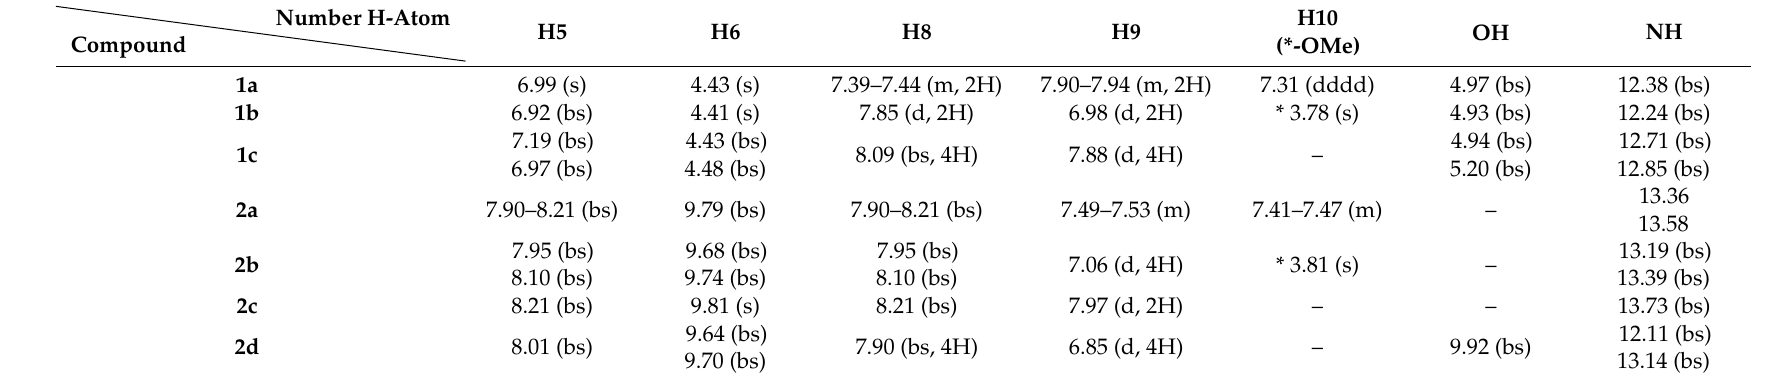
Table 1. Assignments of the signals from the 1 H NMR spectra of compounds 1a – c and 2a – d , all obtained in DMSO- d 6 at 298 K and concentration 0.05 M. Atoms numbering is shown in Figure